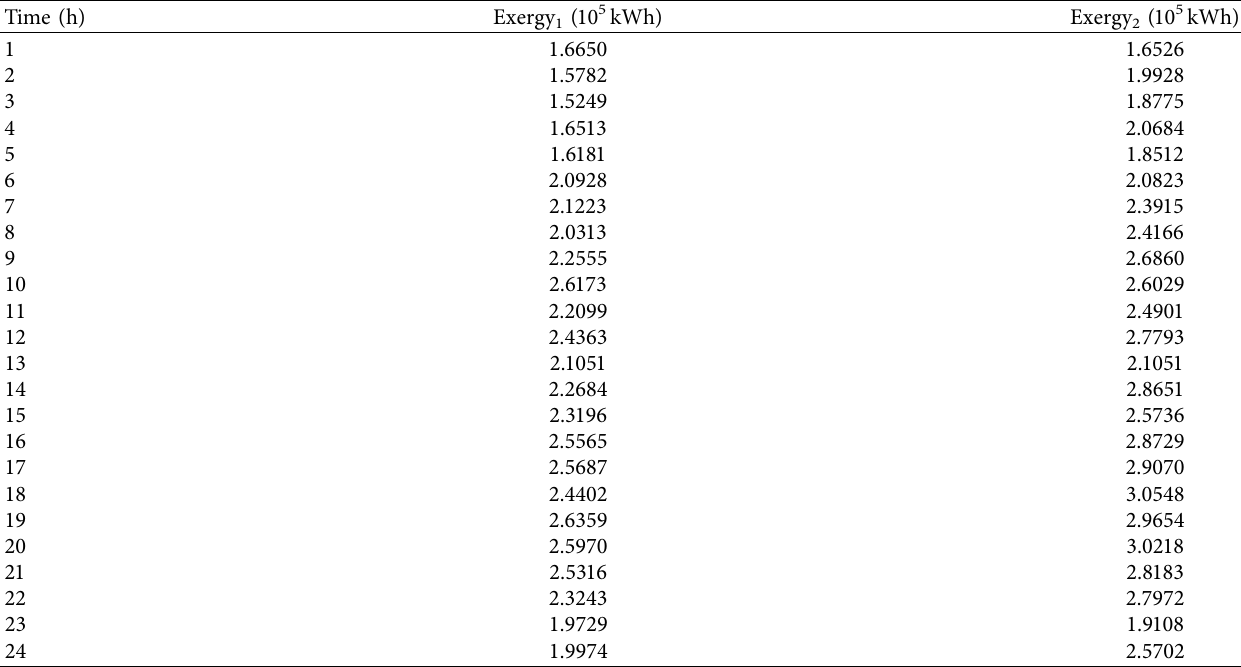
Table 5: Exergy input in